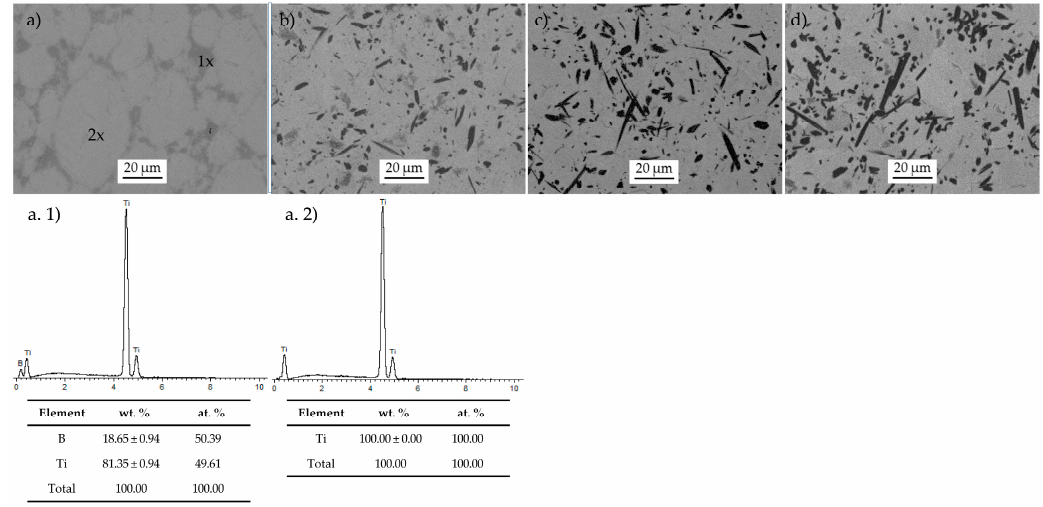
Figure 3. SEM images of TMCs made from starting powder with 5 vol % of amorphous B and manufactured at: ( a ) 1000 °C; ( b ) 1100 °C; ( c ) 1200 °C; and ( d ) 1300 °C. ( a1 ) EDS spectra spot (1), ( a2 ) EDS spectra spot (2).